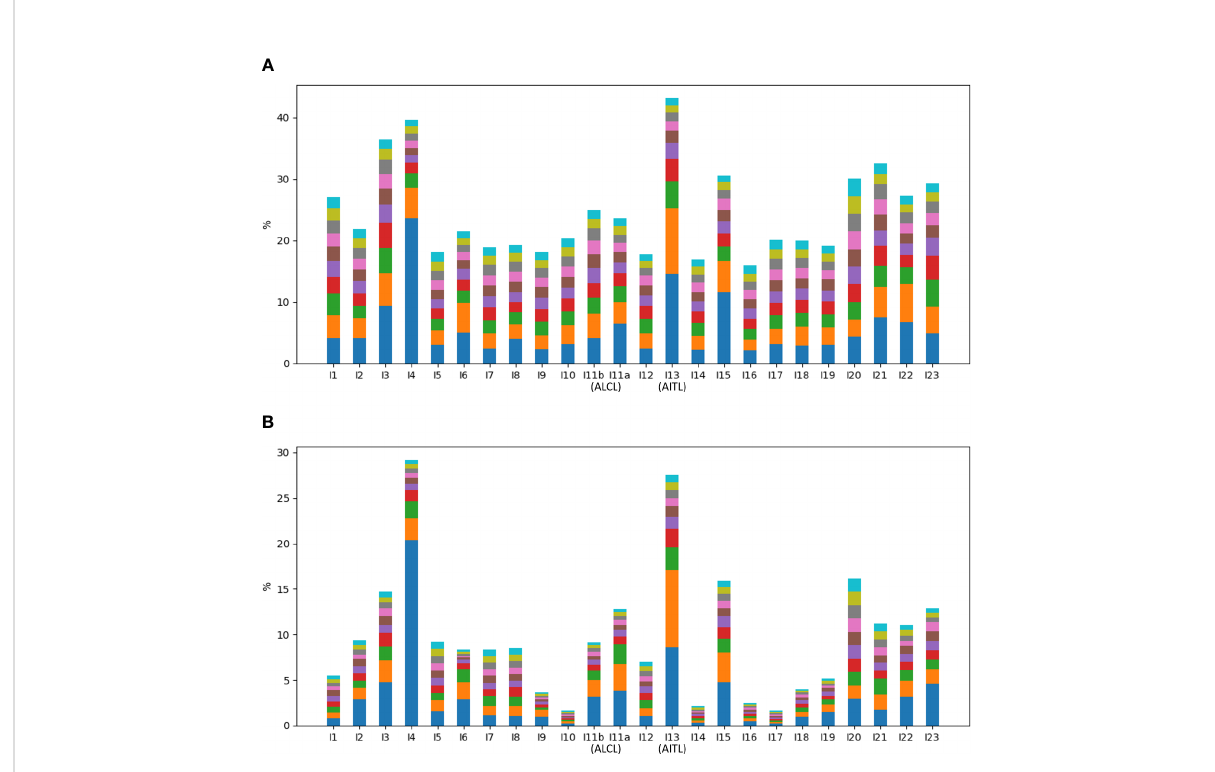
FIGURE 3 Percentages of top ten abundant (A) VJ pairings and (B) CDR3 clonotypes in all